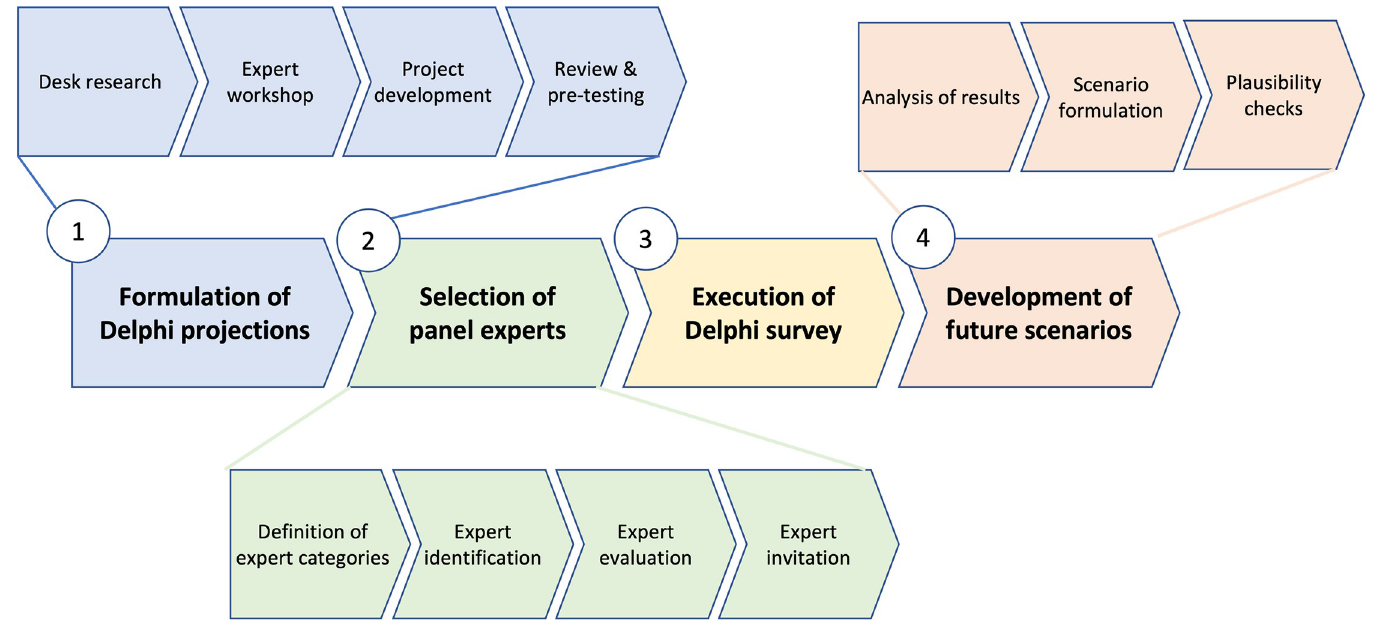
Fig 1. Four Steps Delphi procedure by Heiko and Darkow (2010).